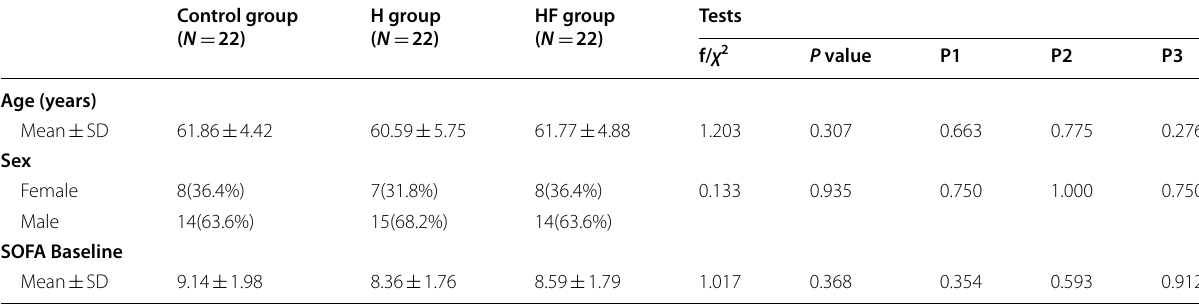
SD standard deviation, N number, H group group receiving hydrocortisone, HF group group receiving hydrocortisone plus fludrocortisone, P1 comparison between the control group and H group, P2 comparison between the control group and HF group, P3 comparison between the H group and HF